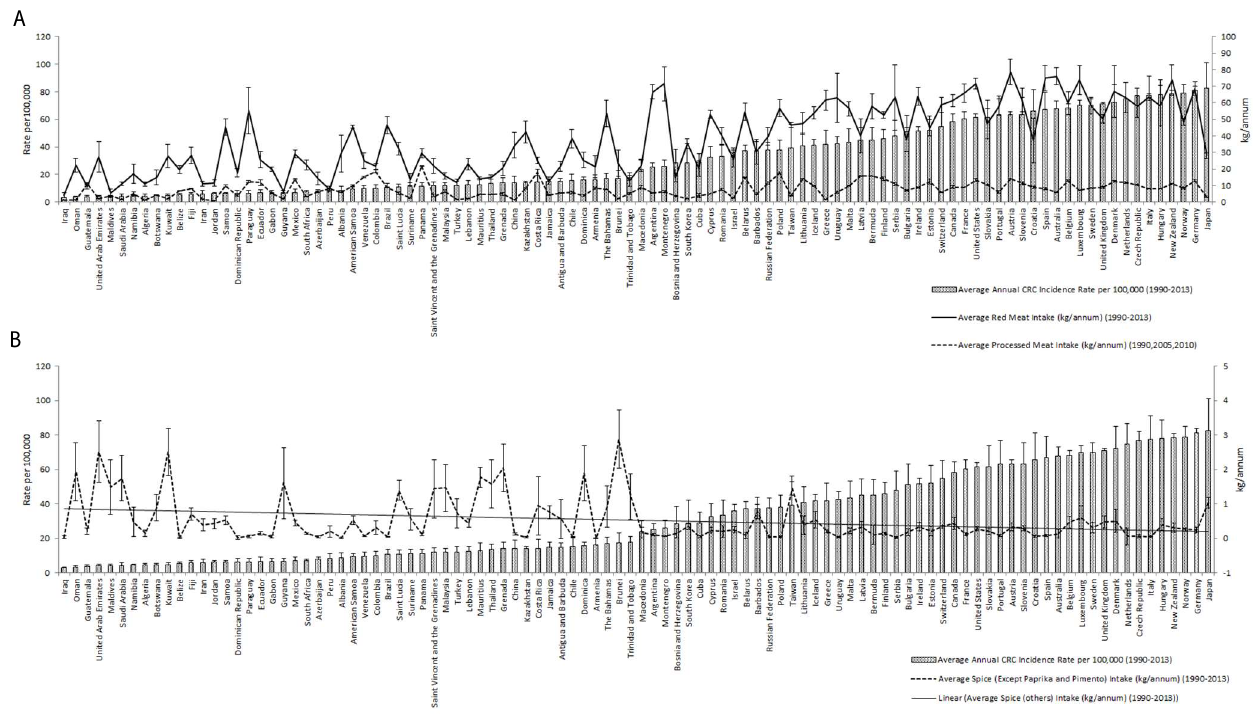
Figure 2 . Data Visualisation According to The Ascending Order of Colorectal Cancer (CRC) Incidence and Food Intake Pattern. A. Red Meat and Processed Meat Intake (kg/annum) Plot Shows Increasing Trend of Intake Along with Increasing Cancer Risk. B. Graph Shows a Decreasing Trend of Spice Intake (Kg/annum) with Increasing CRC Incidence